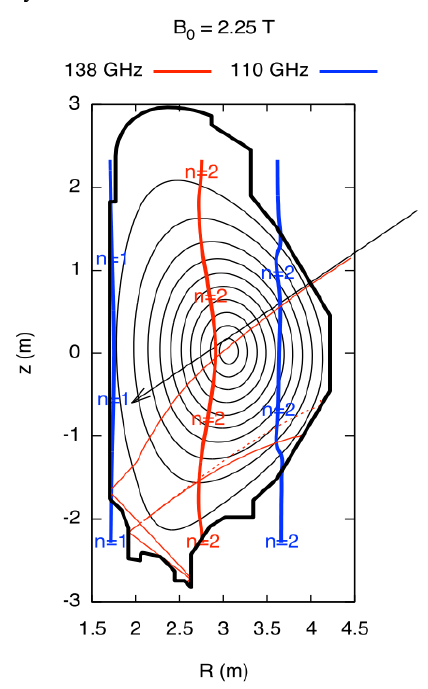
Fig. 4. Beam trajectory (red lines) and EC resonances for the harmonic n for scenario 2 at nominal magnetic field. The black arrow represents the initial injection direction. Applies to case 1.